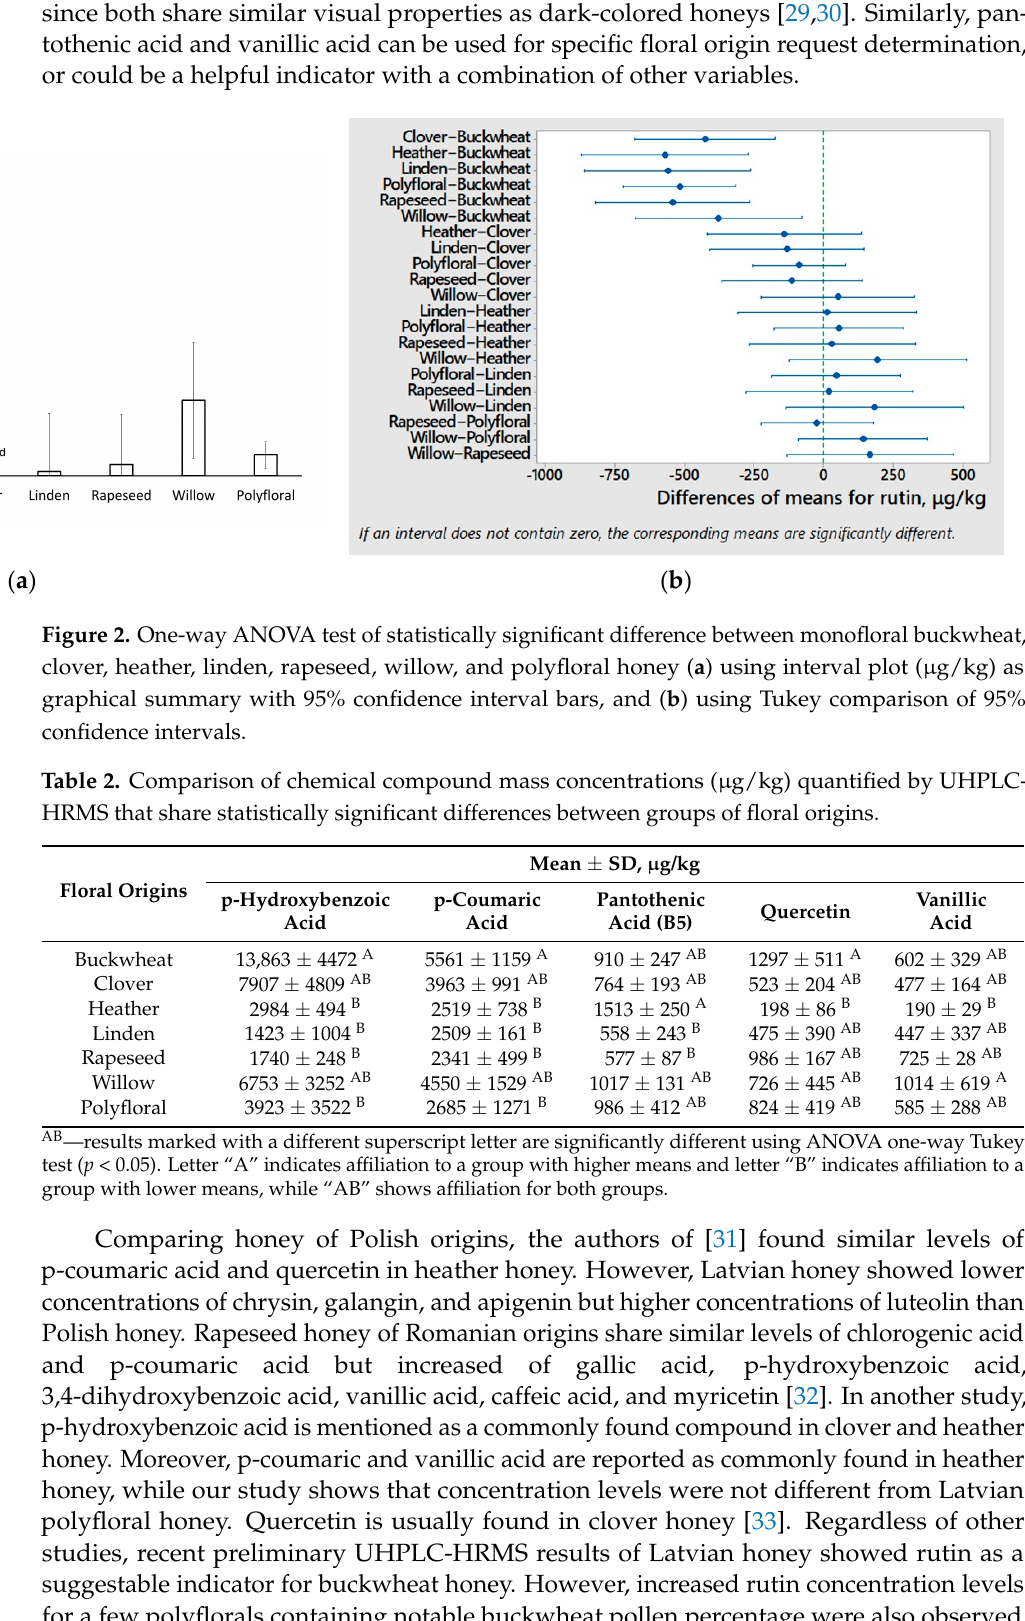
Table 2. Comparison of chemical compound mass concentrations ( μ g/kg) quantified by UHPLC- HRMS that share statistically significant differences between groups of floral origins.